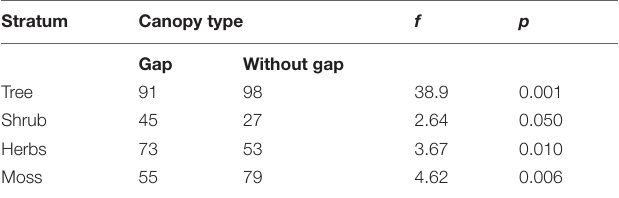
TABLE 1 | Mean coverage (%) of different forest strata per canopy type (with and without gap), and significance of the difference between canopy types in each case.